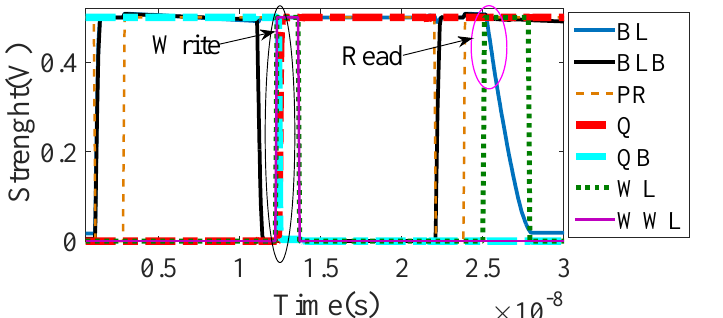
Figure 8. Read and write waveform and important signals for proposed second 12T SRAM cell at 0.5 V supply voltage.